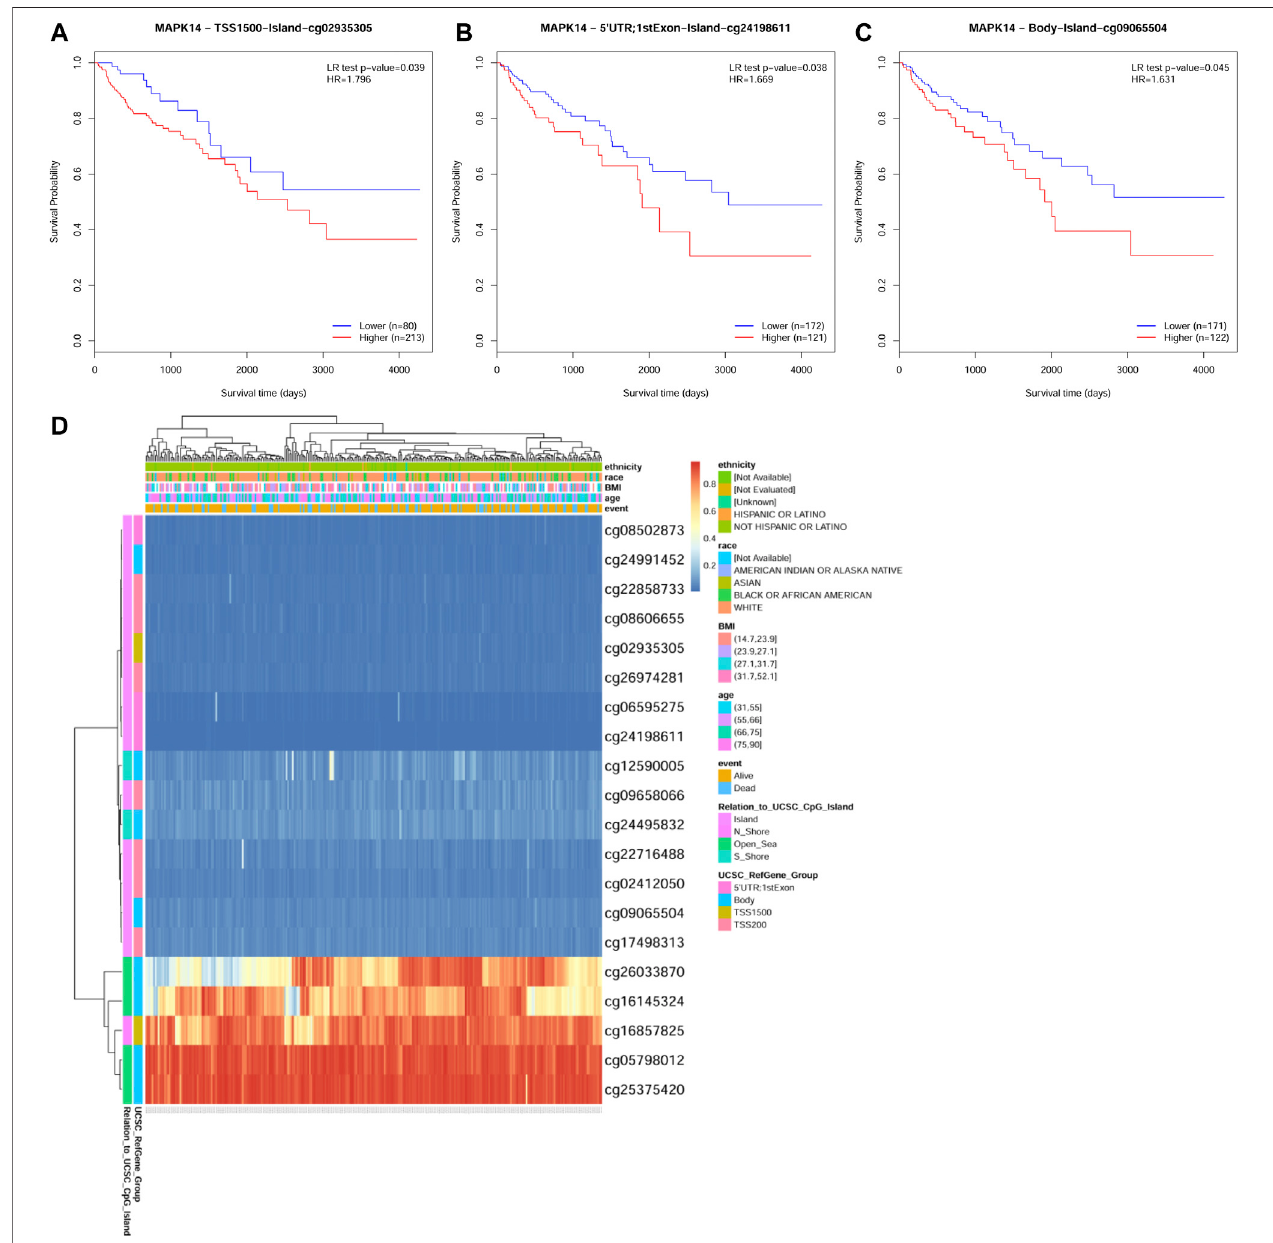
FIGURE 5 | MethSurv database analysis of the effect of MAKK14 gene methylation levels on the prognosis of COAD. (A – C) Kaplan-Meier survival of Mapk14 promoter methylation in COAD was observed (cg02935305, cg24198611 and cg09065504. p < 0.05). (D) Visualization of the relationship between methylation levels and Mapk14 expression in